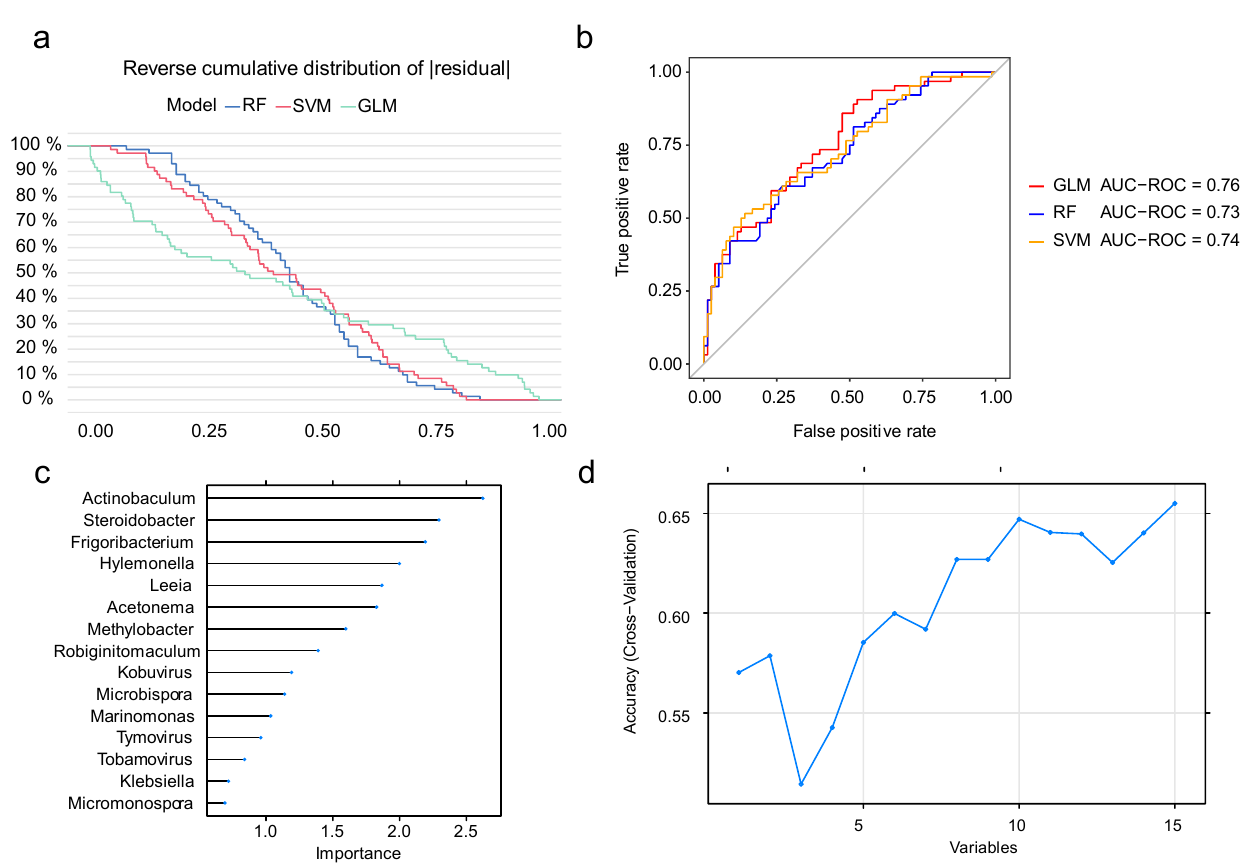
Figure 3. Model construction and feature screening using machine learning algorithms. ( a ) Diagram of the reverse cumulative distribution of residuals in the RF, GLM, and SVM models; ( b ) ROC curves and AUC values for the three models; ( c ) ranking of feature importance; and ( d ) feature–accuracy curves for generalized linear models. RF, random forest; GLM, generalized linear model; SVM, support vector machine.